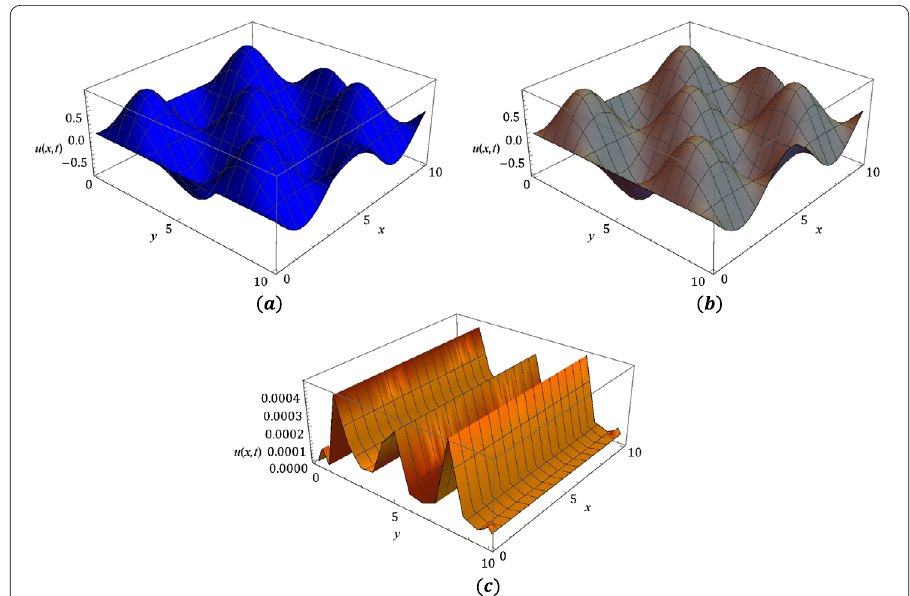
Figure 3 Surfaces ( a ) q -HATM solution ( b ) analytical solution ( c ) absolute error defined in Case 2 at (cid:2) = –1, n = 1, t = 0.1 and α = 1